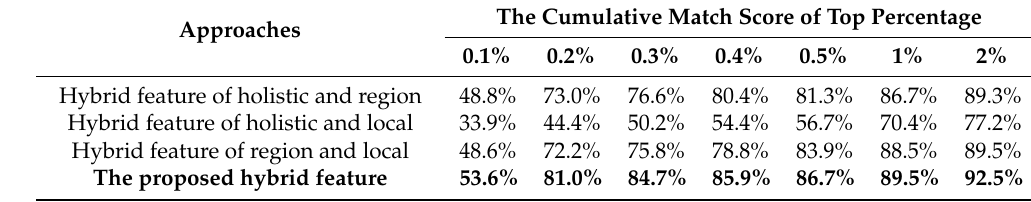
Table 7. Performance of the proposed method with the three kinds of features.